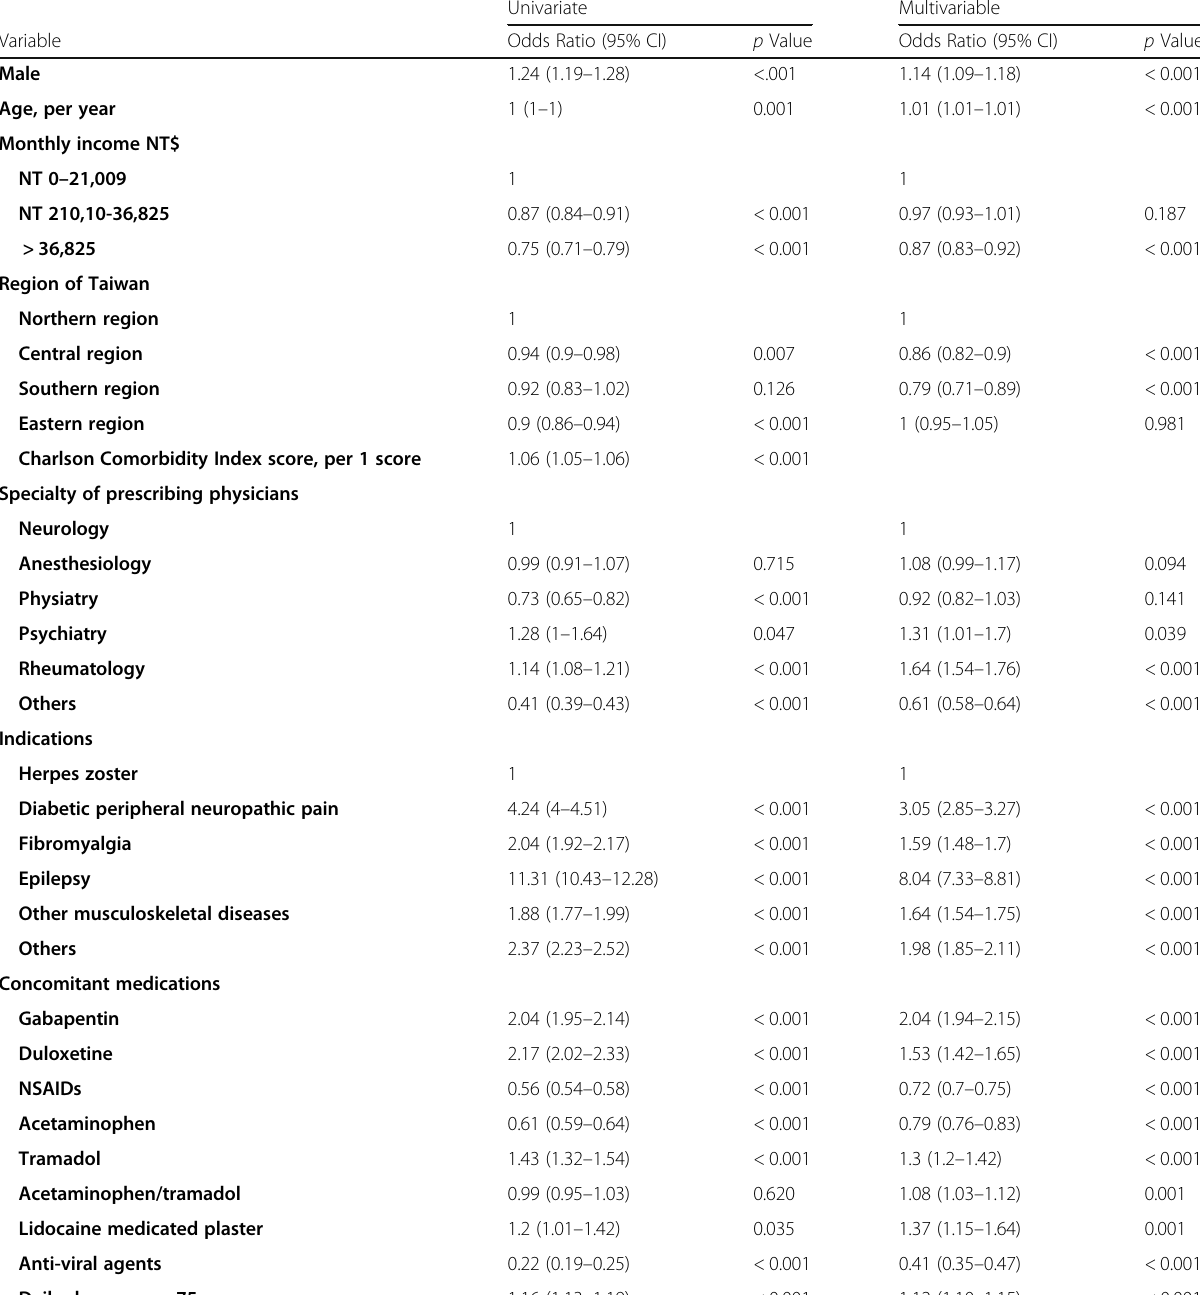
Table 4 Factor associated with persistent use of pregabalin at one